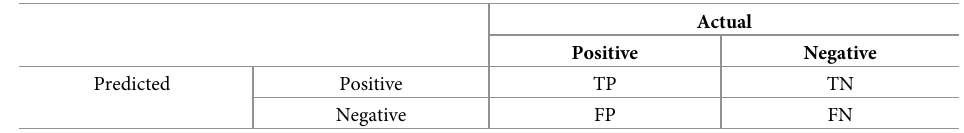
Table 1. Confusion